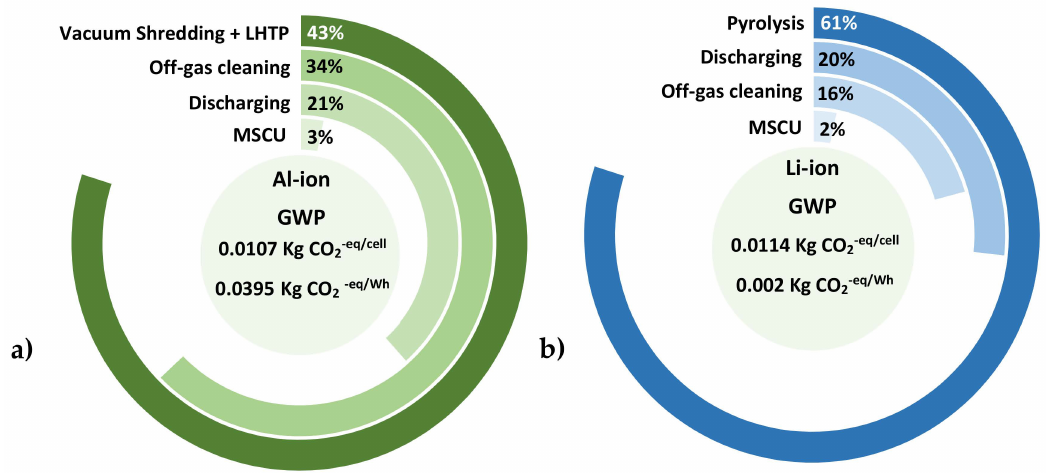
Figure 7. Comparison of the GWP contribution by the Al-ion’s ( a ) and Li-ion’s ( b ) recycling processes. Figure ( a ) shows the Al-ion recycling process with the total impact of 0.0107 kg of CO 2 − eq in a cell basis and 0.0395 kg of CO 2 − eq in a storage capacity basis. The main contributor, in this case, is the vacuum-shredding + LTHP. Figure ( b ) presents the Li-ion recycling process. This process performs poorer in comparison with the Al-ion recycling process due to pyrometallurgical operations. In this case, the total GWP contribution was estimated to be 0.0114 kg of CO 2 − eq in a cell basis and 0.002 kg of CO 2 − eq in a storage capacity